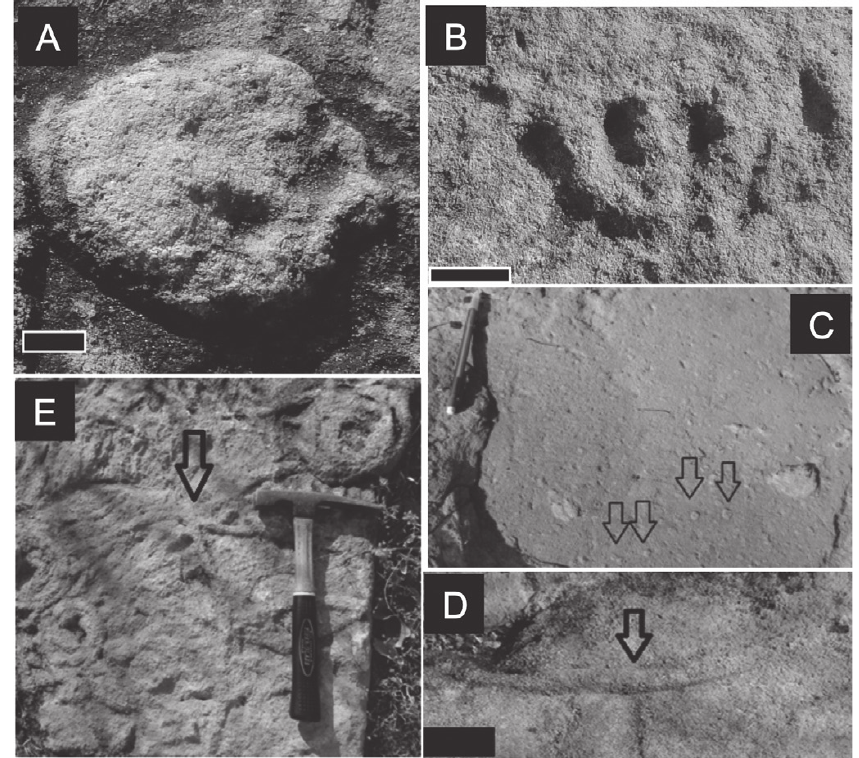
Figure 5 - Ediacaran fauna: A , Parvancorina minchami (Scale 1 cm); B , Pectinifrons abyssalis (Scale 3 cm); and ichnofossiliferous association: C , Arenicolites Salter, 1857 (Scale 15 cm); D , Palaeophycus Hall, 1987 (Scale 3 cm); E , Planolites Nicholson, 1873 (Scale 20